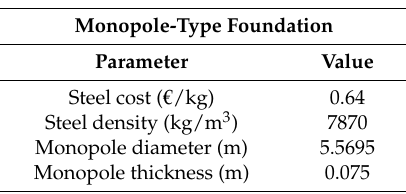
Table 9. Wind turbine tower’s cost estimation parameters.